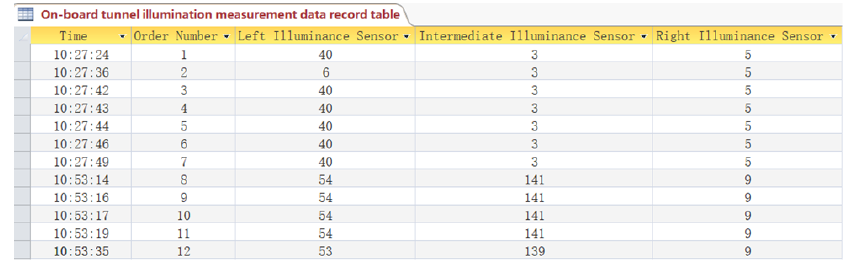
Figure 9. Access database interface at 10:00.